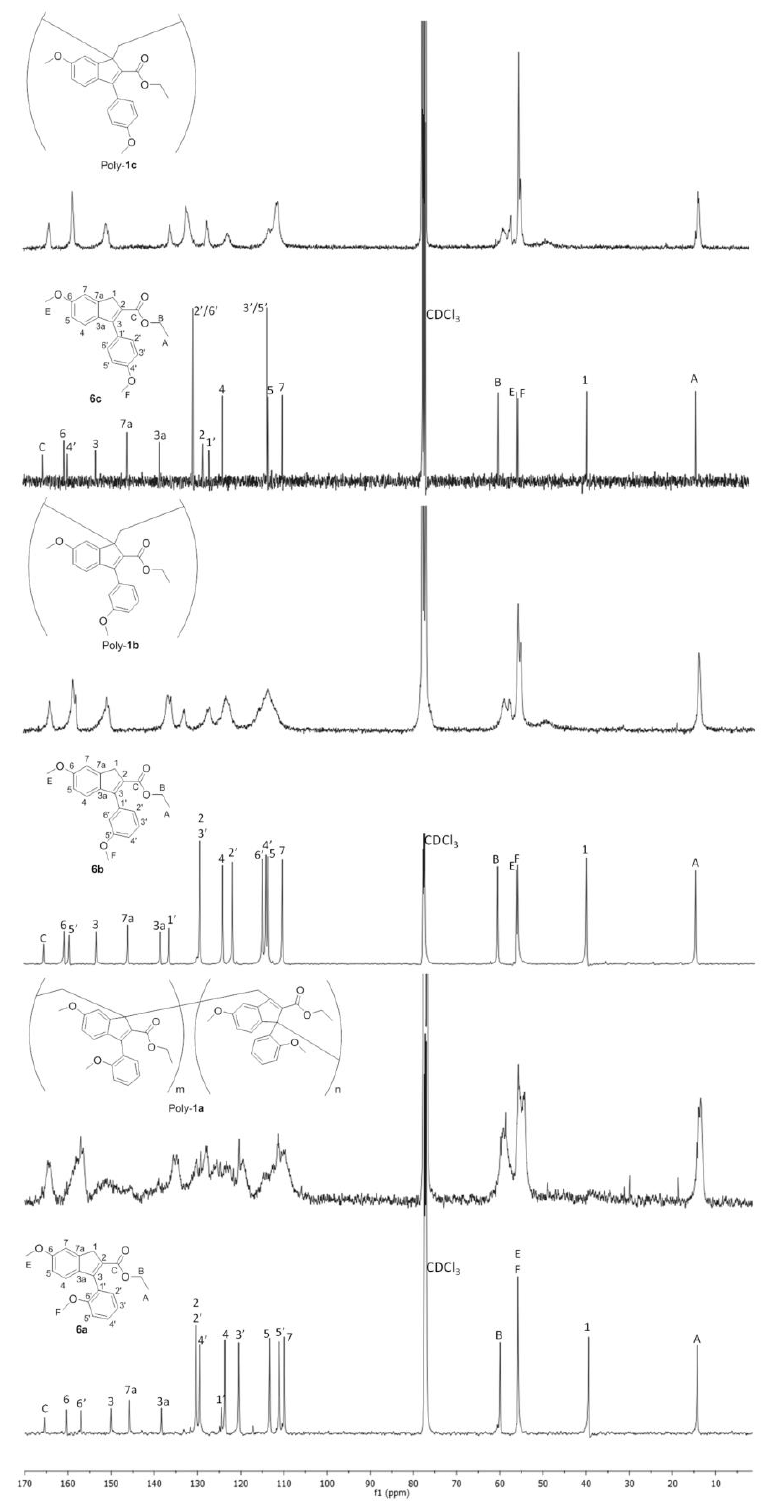
Figure 4. 13 C NMR spectra (CDCl 3 ) of the polymers poly- 1a – c in comparison with the corresponding monomeric unit models 6a – c .